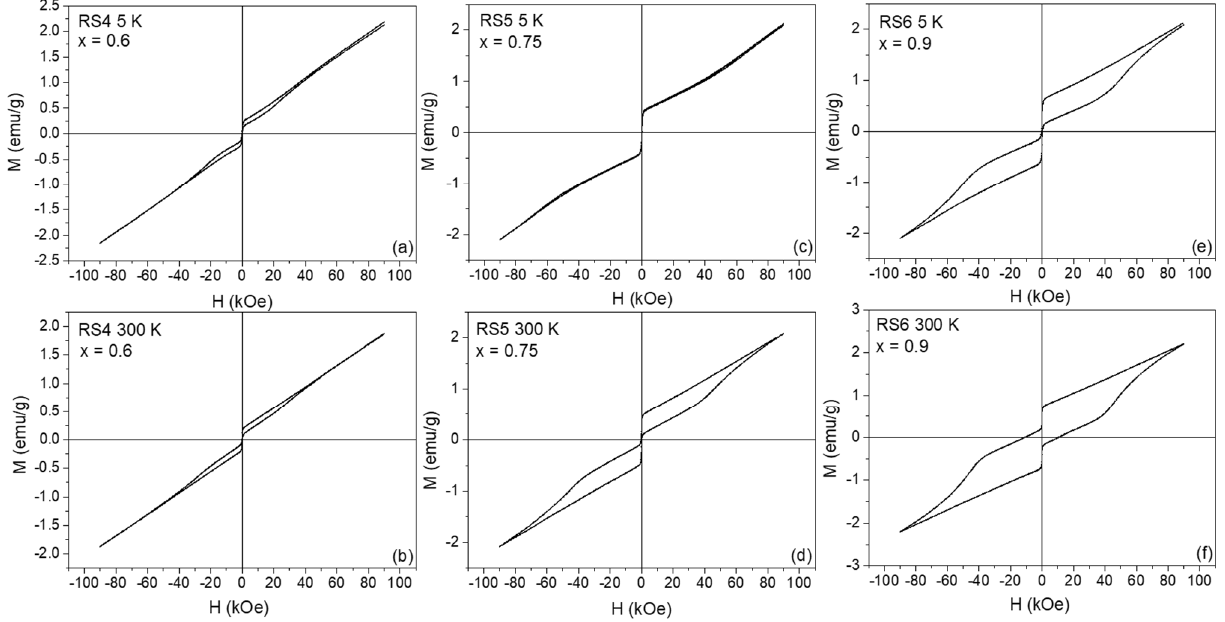
Figure 4. M(H) curves recorded for a maximum field of 90 kOe at 5 (top) and 300 K (bottom) for the RSX samples. RS4 in ( a ) and ( b ), RS5 in ( c ) and ( d ), and RS6 in ( e ) and ( f ), respectively.